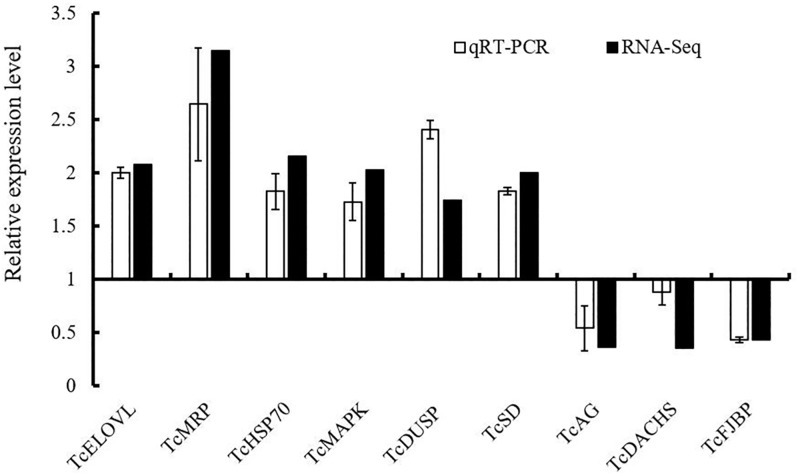
qRT-PCR analysis of selected transcripts to confirm expression profiles identified by RNA-seq.TcELOVL, elongation of very long chain fatty acids protein 7; TcMRP, ATP-binding cassette subfamily C (CFTR/MRP) member 4; TcHSP70, heat shock 70kDa protein; TcMAPK, MAP kinase; TcDUSP, Dual specificity MAP kinase phosphatase; TcSD, superoxide dismutase, Cu-Zn family; TcAG, alpha-glucosidase; TcDACHS, DACHS, Hippo signling pathway; TcFJBP Four-jointed box protein 1 (FJBP). Value represents mean ± SE of three independent PCR amplifications and quantifications.